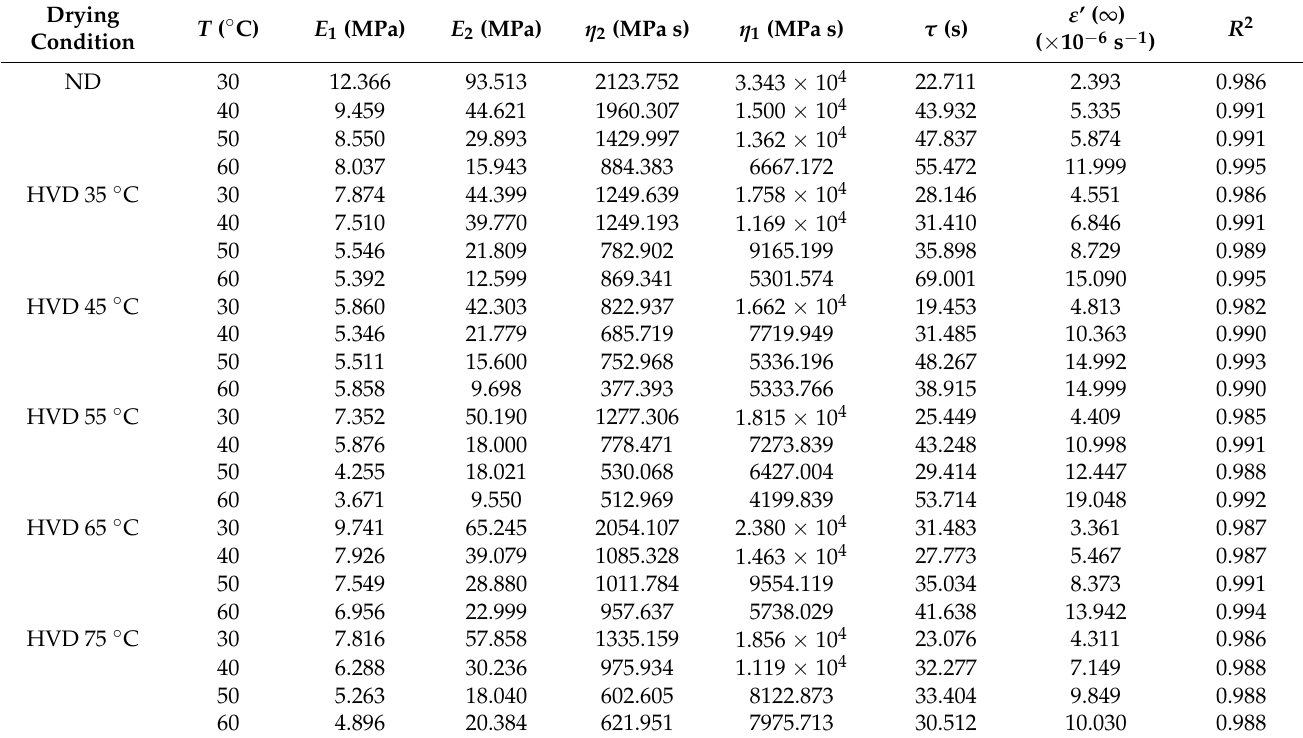
Table 2. Parameters of Burgers’ equation for maize